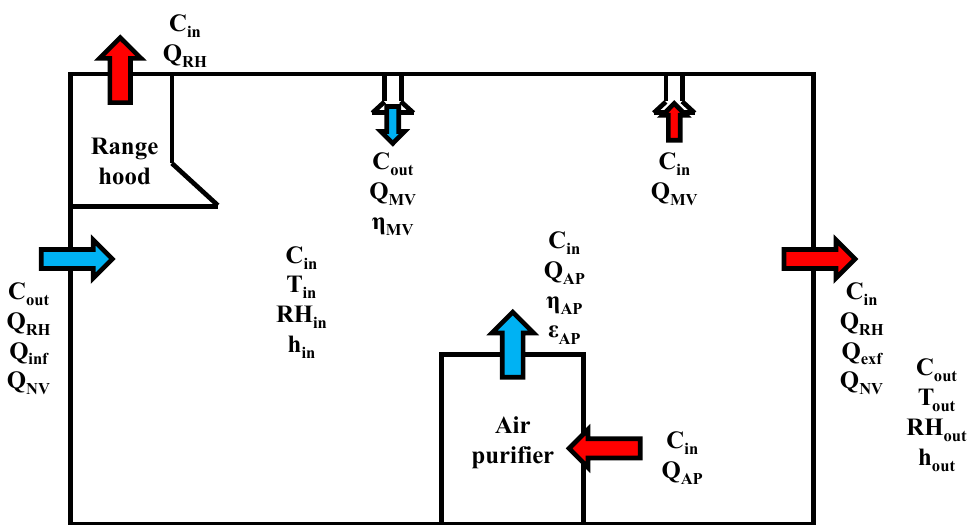
Figure 2. Schematic diagram of theoretical model for indoor PM 2.5 and energy consumption. Red arrows: IAQ management methods to exhaust indoor PM 2.5 . Blue arrows: IAQ management methods to supply outdoor PM 2.5 or clean indoor PM 2.5 .